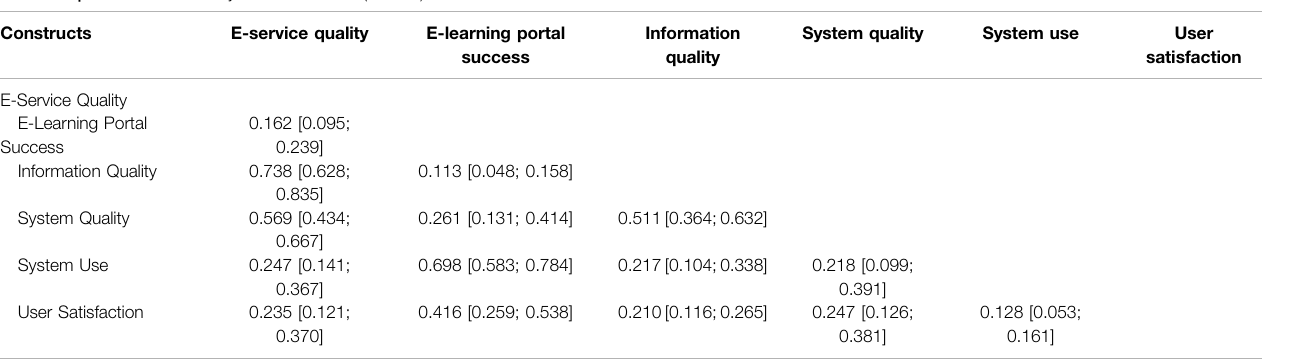
TABLE 7 | Discernment validity: HTMT criterion (Female).